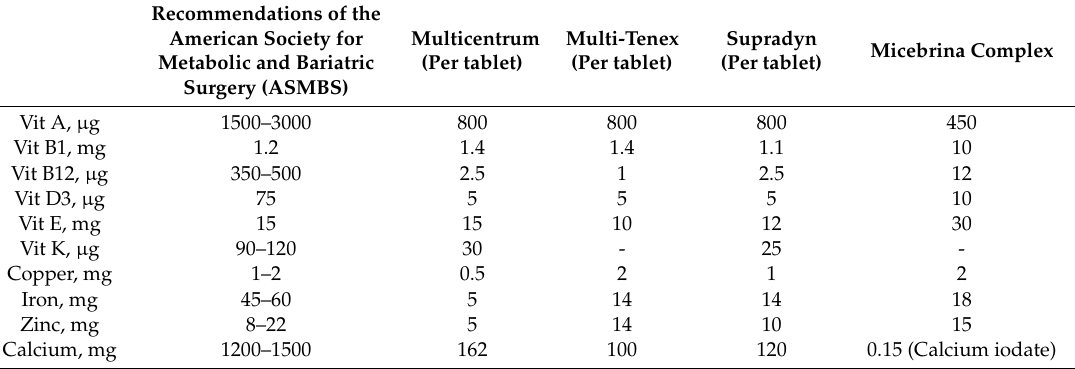
Multicentrum Multi-Tenex Supradyn Micebrina (Per tablet) (Per tablet) (Per tablet)